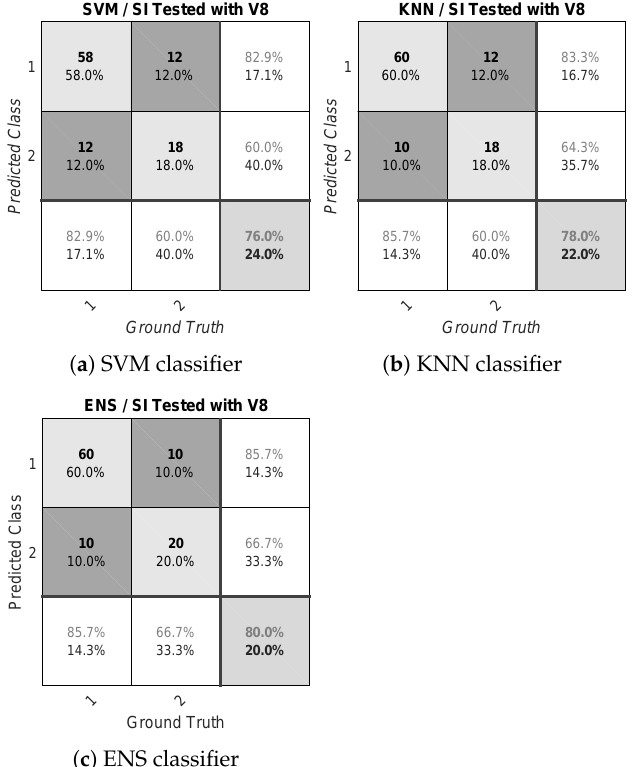
Figure A18. Confusion matrices for a subject-independent model tested with